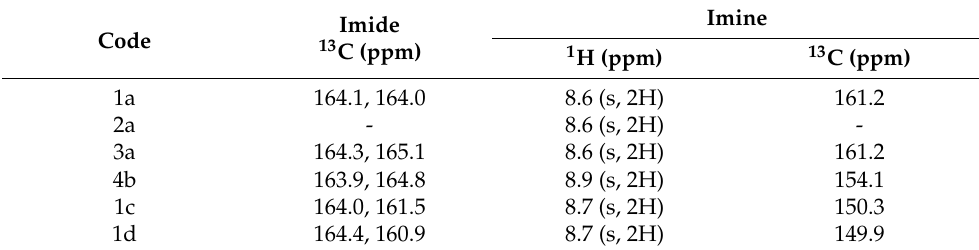
Table 1. Selected NMR chemical shifts (ppm) and multiplicities for compounds.